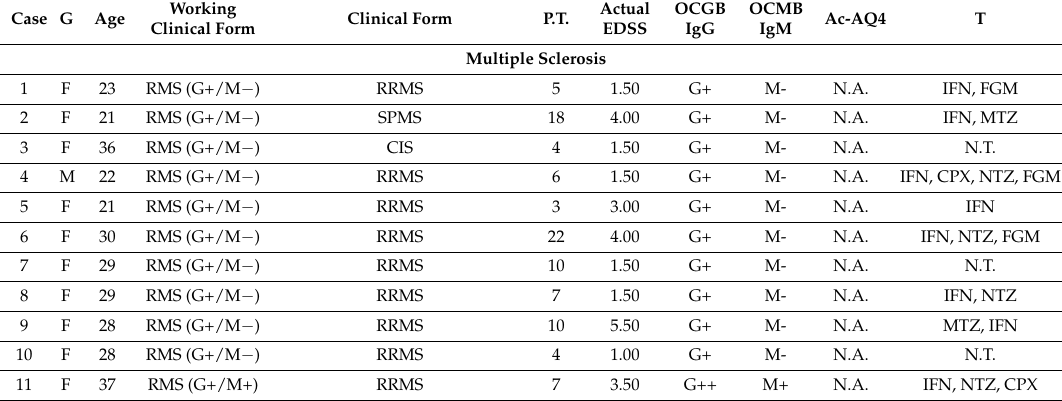
Table 1. Clinical characteristics of the patients. Case = Patient number; G = Gender; F = Female; M = Male; Age = patient age in years; P.T. = progression time (duration of the disease since diagnosis in years); Actual EDSS = Expanded disability status scale; OCGB IgG = oligoclonal IgG bands in CSF; OCMB IgM = oligoclonal IgM bands in CSF; Ac-AQ4 = Antiaquaporin 4 antibodies; T =